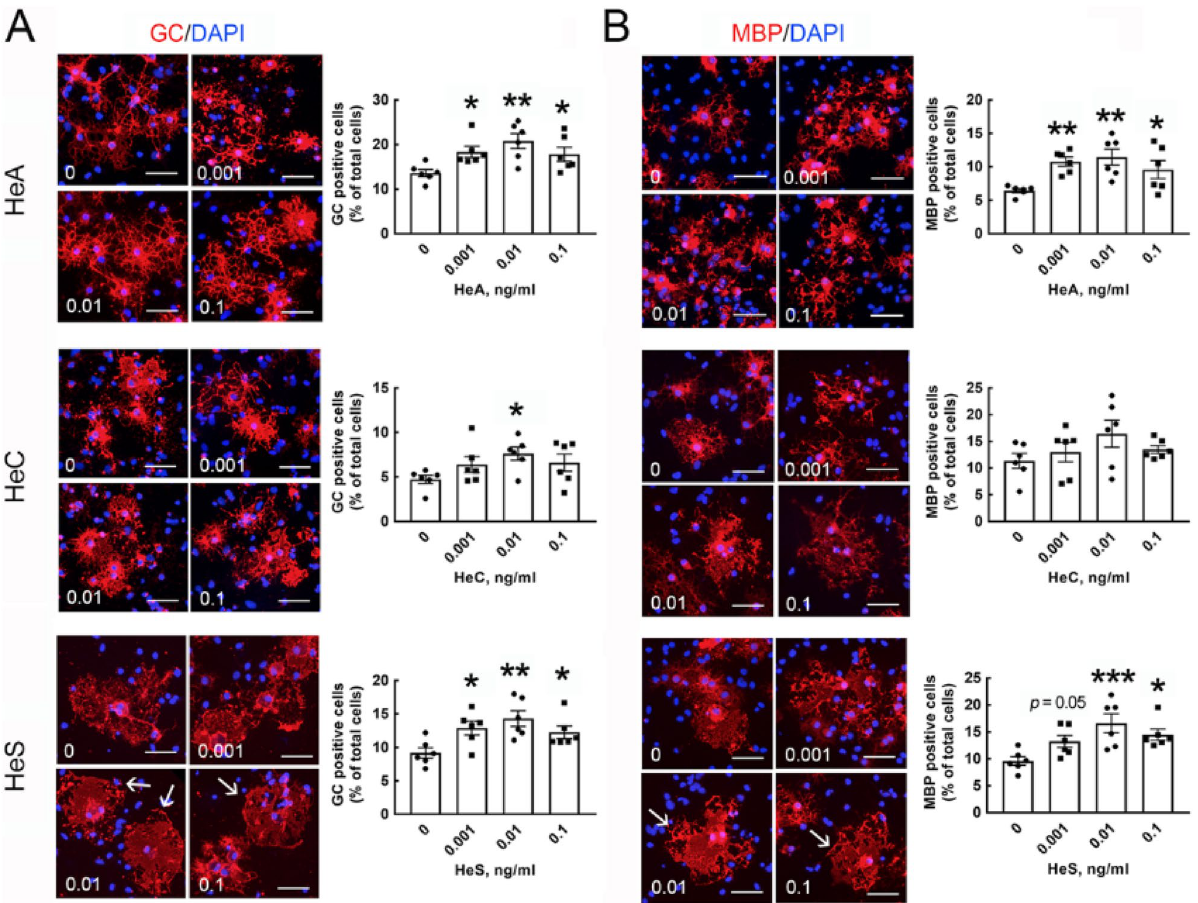
Figure 4. Three HEM-derived compounds promote OL maturation. After OPCs were maintained in DM for 2 days, as described in Fig. 1B, three known HEM-derived compounds (HeA, HeC, HeS) were added to the cultures at the indicated concentrations and incubated for another 3 days. The cultures were processed for GC ( A ) and MBP ( B ) immunofluorescence (red) and DAPI nuclear counterstaining (blue). The OLs with a membranous extension are indicated by arrows in the representative images. GC + - and MBP + -OLs in the cultures were quantified as described in “Materials and methods” section. Each spot represents as the data quantified from one photo captured from the cultures. The experiments were repeated by the three independent cell preparations. * p < 0.05, ** p < 0.01, *** p < 0.001 versus the vehicle-treated control culture. Scale bar, 50